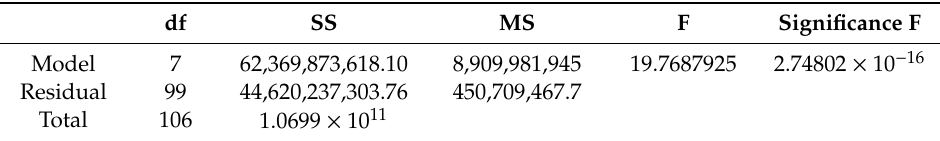
Table 3. Variance analysis